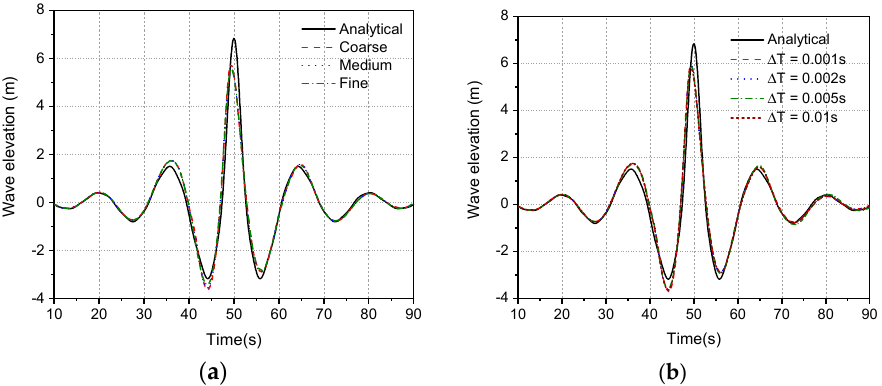
Figure 6. Mesh and time step convergence test of focused wave generation ( H s = 8.0 m, T p = 15.0 s): ( a ) mesh density; ( b ) time step.